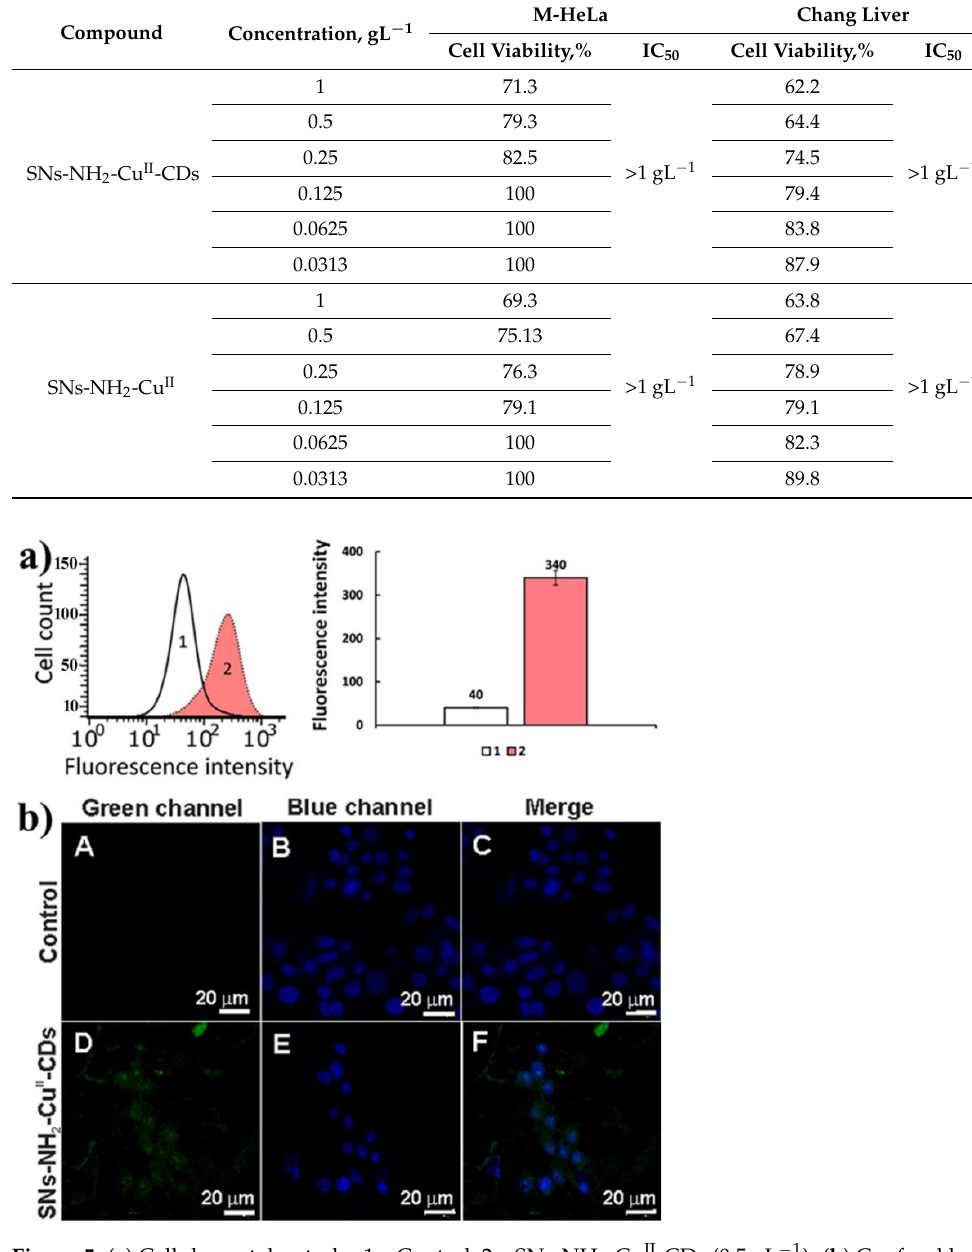
Figure 5. ( a ) Cellular uptake study: 1 — Control; 2 — SNs-NH 2 -Cu II -CDs (0.5 gL −1 ). ( b ) Confocal laser microscopy images of the control M-Hela cell lines ( A – C ) and cells incubated with SNs-NH 2 -Cu II -CDs ( D – F ) at 0.5 gL −1 stained with DAPI.